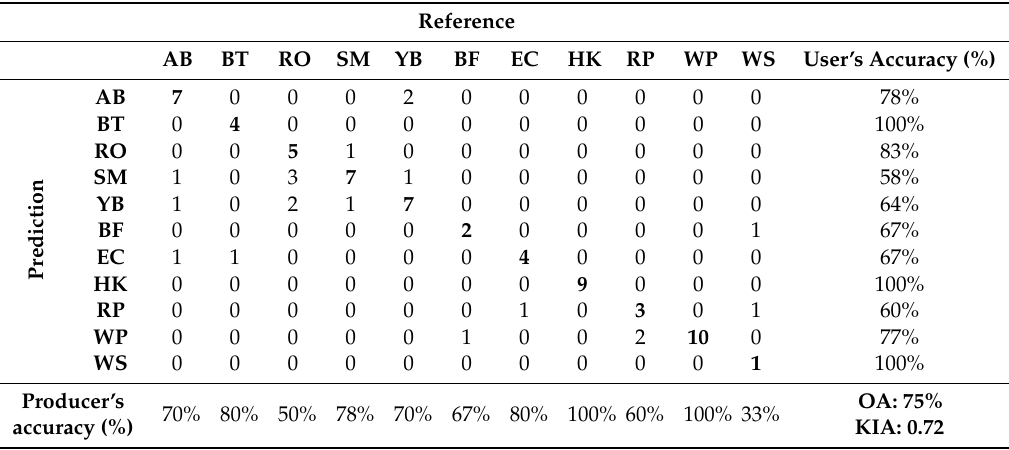
Table 9. Confusion matrix of the RF model for the global approach. AB: American Beech, BT: Big Tooth Aspen, RO: Red Oak, SM: Sugar Maple, YB: Yellow Birch, BF: Balsam Fir, EC: Eastern White Cedar, HK: Eastern Hemlock, RP: Red Pine, WP: White Pine, WS: White Spruce. OA: Overall accuracy, KIA: Kappa Index of agreement.